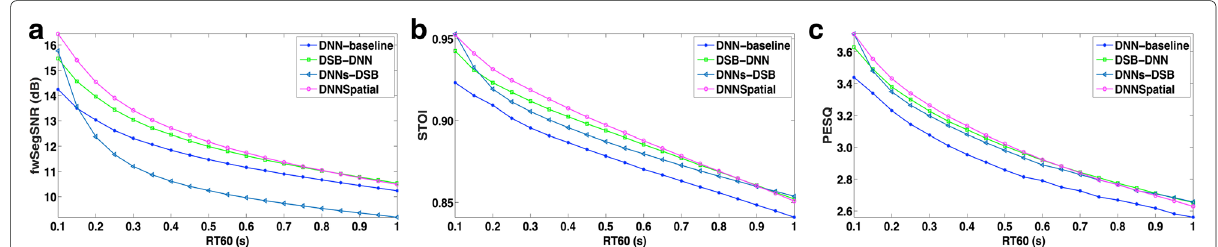
Fig. 8 Average 6-microphone fwSegSNR ( a ), STOI ( b ) and PESQ ( c ) of three DNN-based array dereverberation systems at different